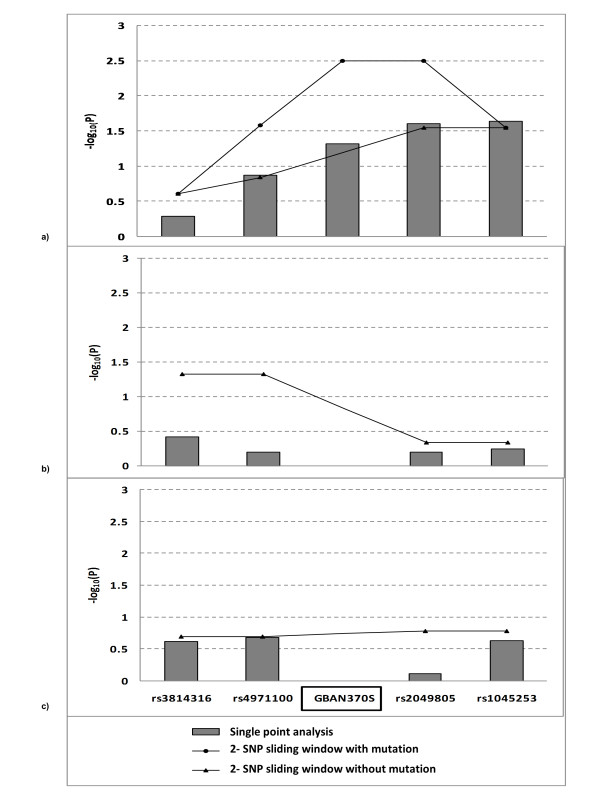
Association and haplotype analysis of GBA mutation (GBA N370S) and flanking SNPs in 3 datasets. a) Single point analysis plus 2 haplotype analyses: with vs. without the mutation in Ashkenazi Jewish. b) Single and haplotype analyses without mutation in NINDS. c) Single and haplotype analyses without mutation in CIDR/Pankratz et al 2009. 2-SNP sliding window, the strongest p-value was present from the exhaustive search.